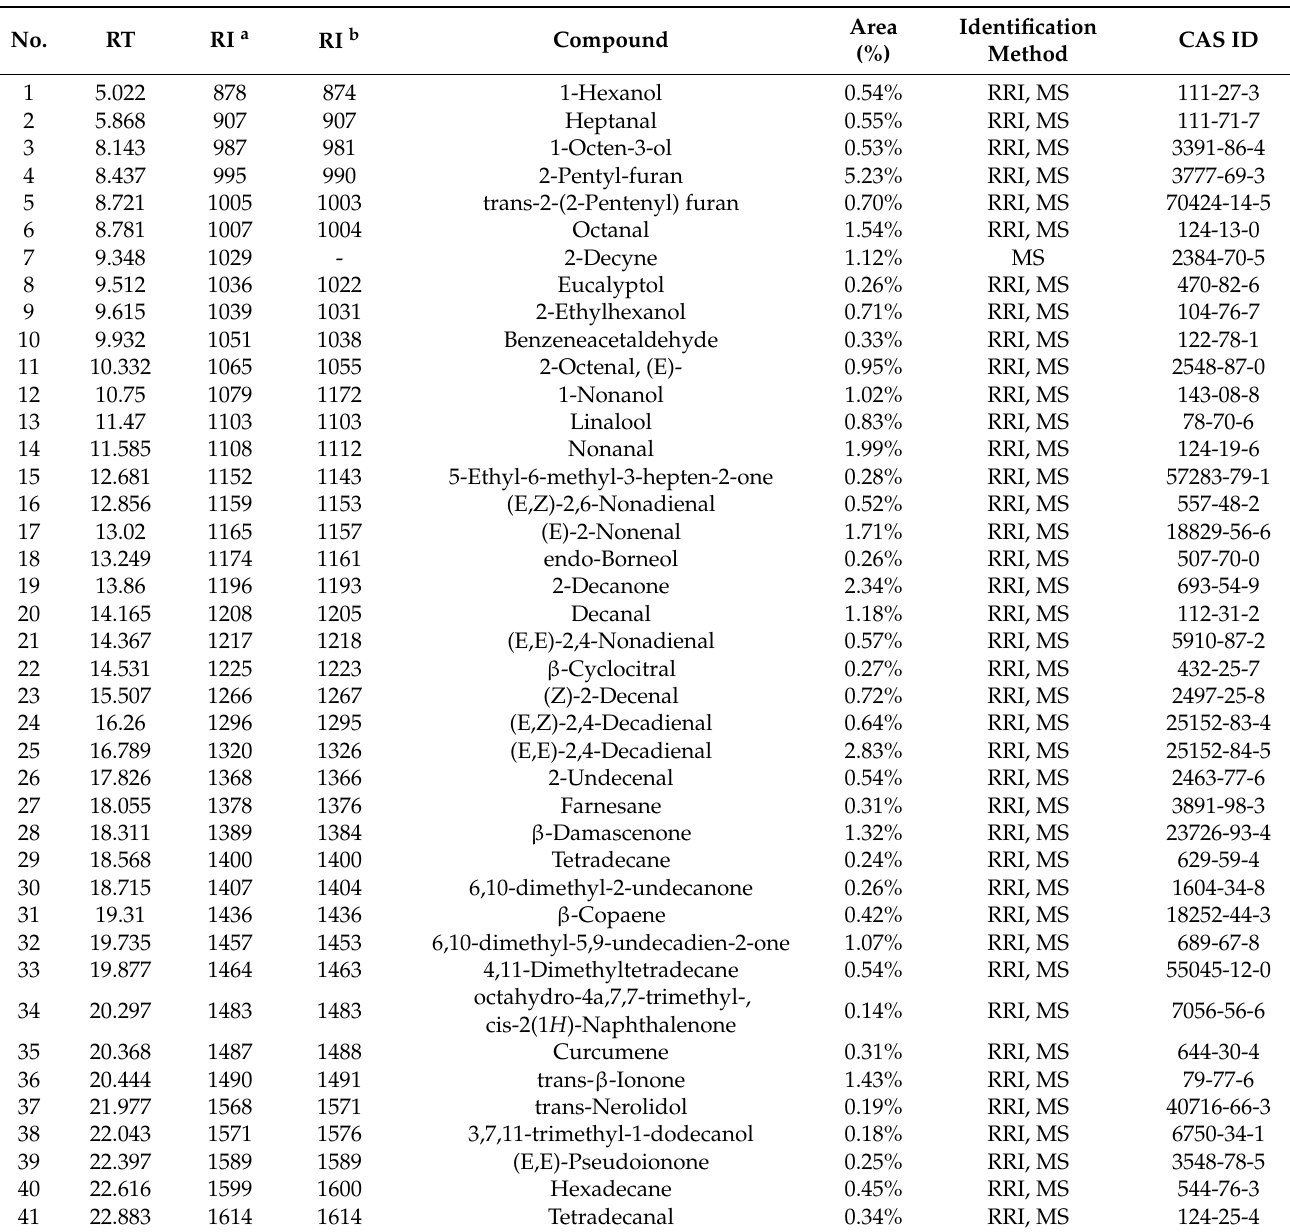
Figure 2. Ion chromatogram of S. rhombifolia volatile organic compounds derived from GC – MS. Table 1. Chemical composition of VOCs distilled from S. rhombifolia .